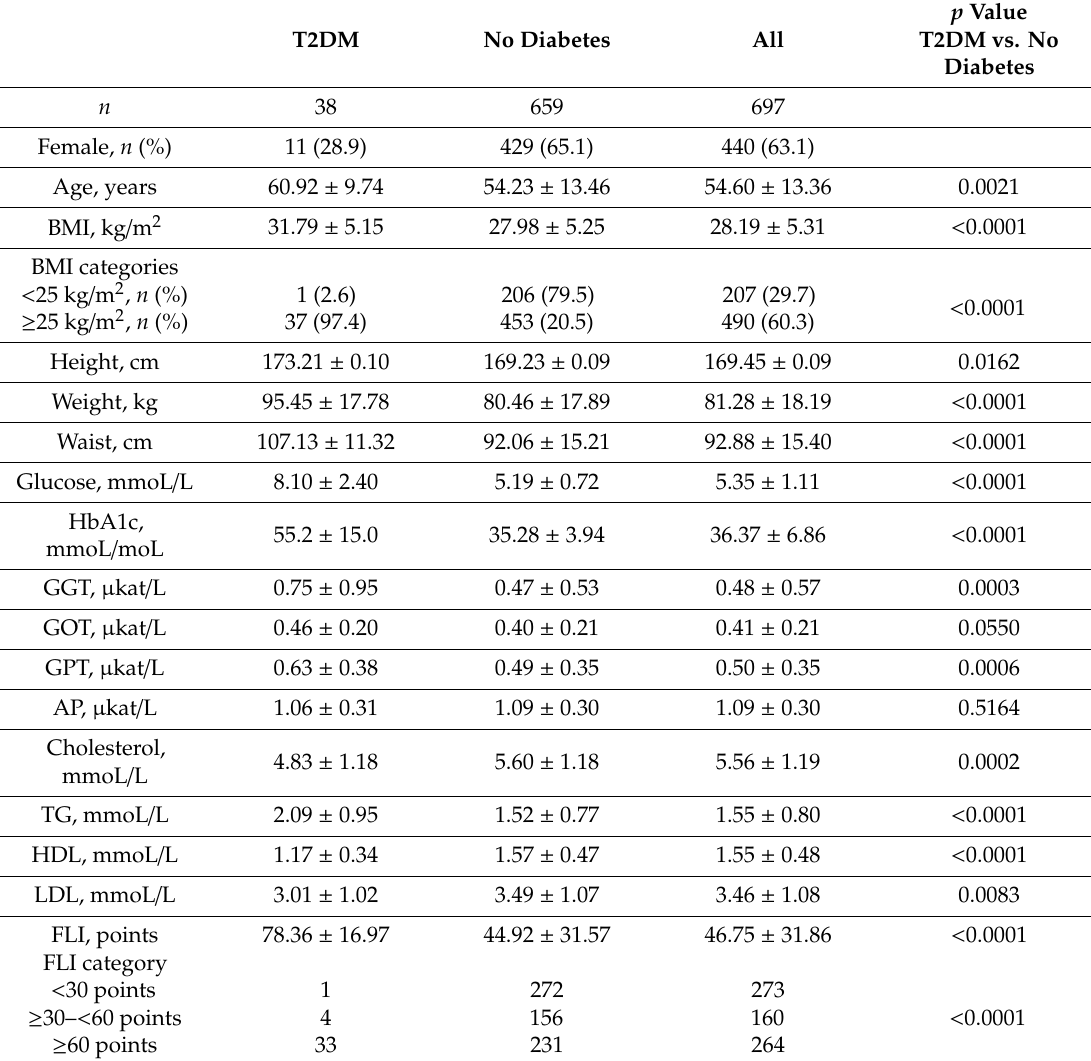
Table 1. Baseline characteristics, comparisons of subjects with and without type 2 diabetes